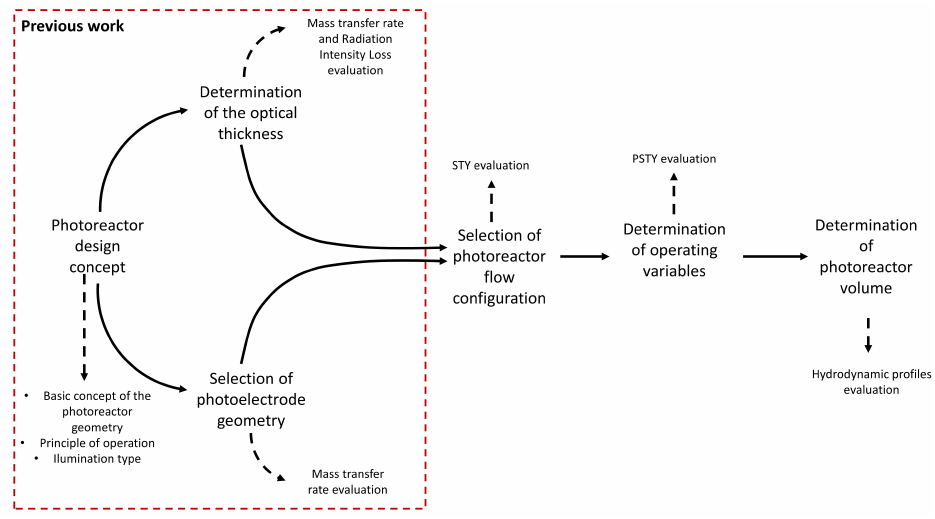
Figure 1. General procedure to design a photoelectrocatalytic